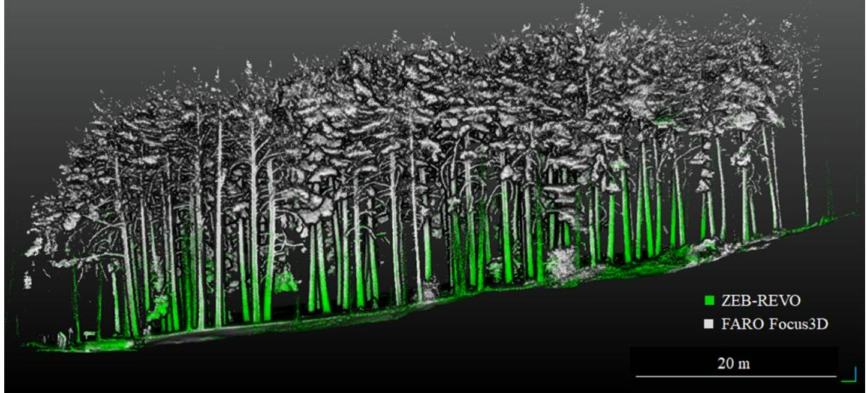
Figure 14. Final forest 3D model in the same coordinate system for test site B.